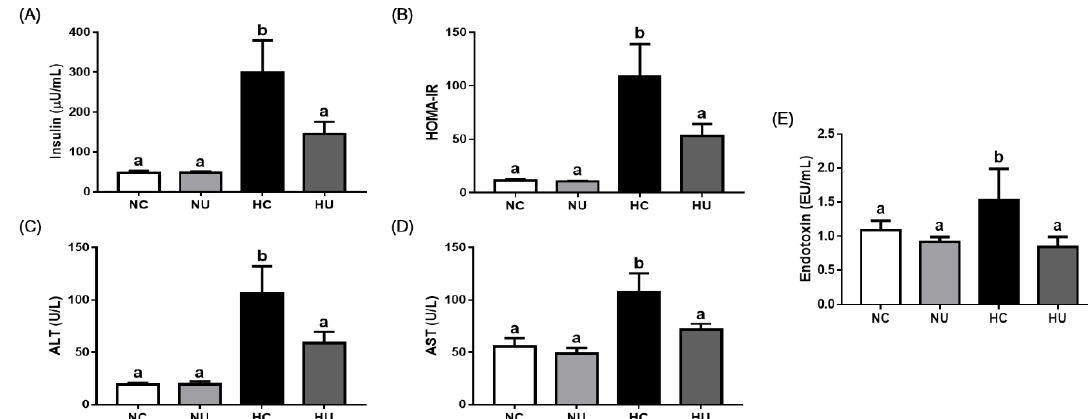
Figure 2. Effects of Bacteroides uniformis CBA7346 treatment on metabolic parameters in mice with high-fat diet-induced non-alcoholic fatty liver disease. ( A ) Serum insulin; ( B ) HOMA-IR index; ( C ) serum ALT; ( D ) serum AST; ( E ) serum LPS. NC, control group on normal diet; NU, group on normal diet receiving 1 × 10 6 CFU B. uniformis CBA7346 thrice a week; HC, control group on high-fat diet; HU, group on high-fat diet receiving 1 × 10 6 CFU B. uniformis CBA7346 thrice a week. Data are presented as mean ± SEM ( n = 9). Means with different letters (a,b) indicate significant difference ( p < 0.05) among groups. Groups were compared using Duncan’s multiple range tests.